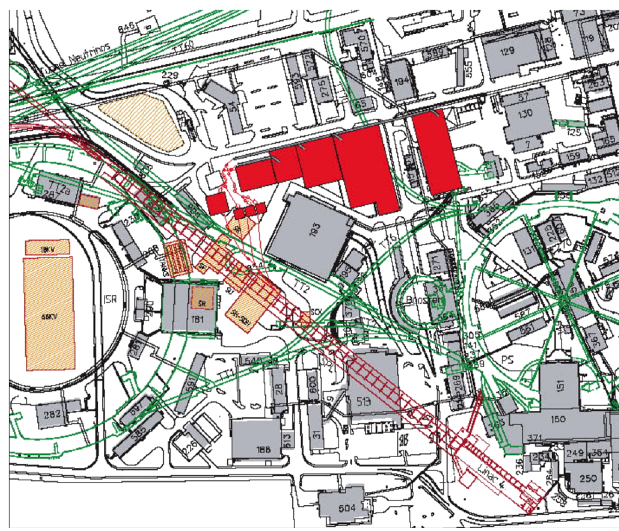
FIG. 1. (Color) Layout of a possible EURISOL facility at CERN (in red above building